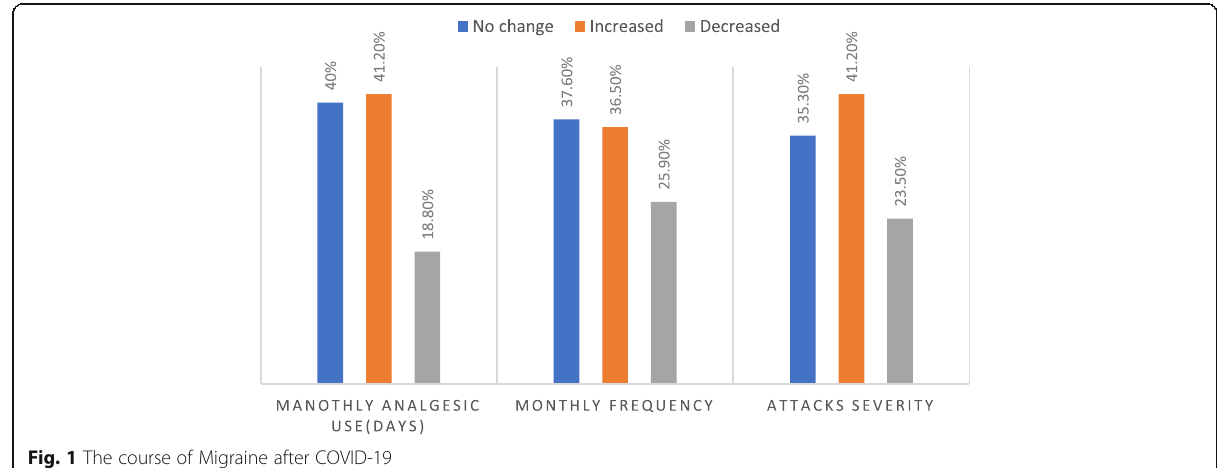
Fig. 1 The course of Migraine after COVID-19